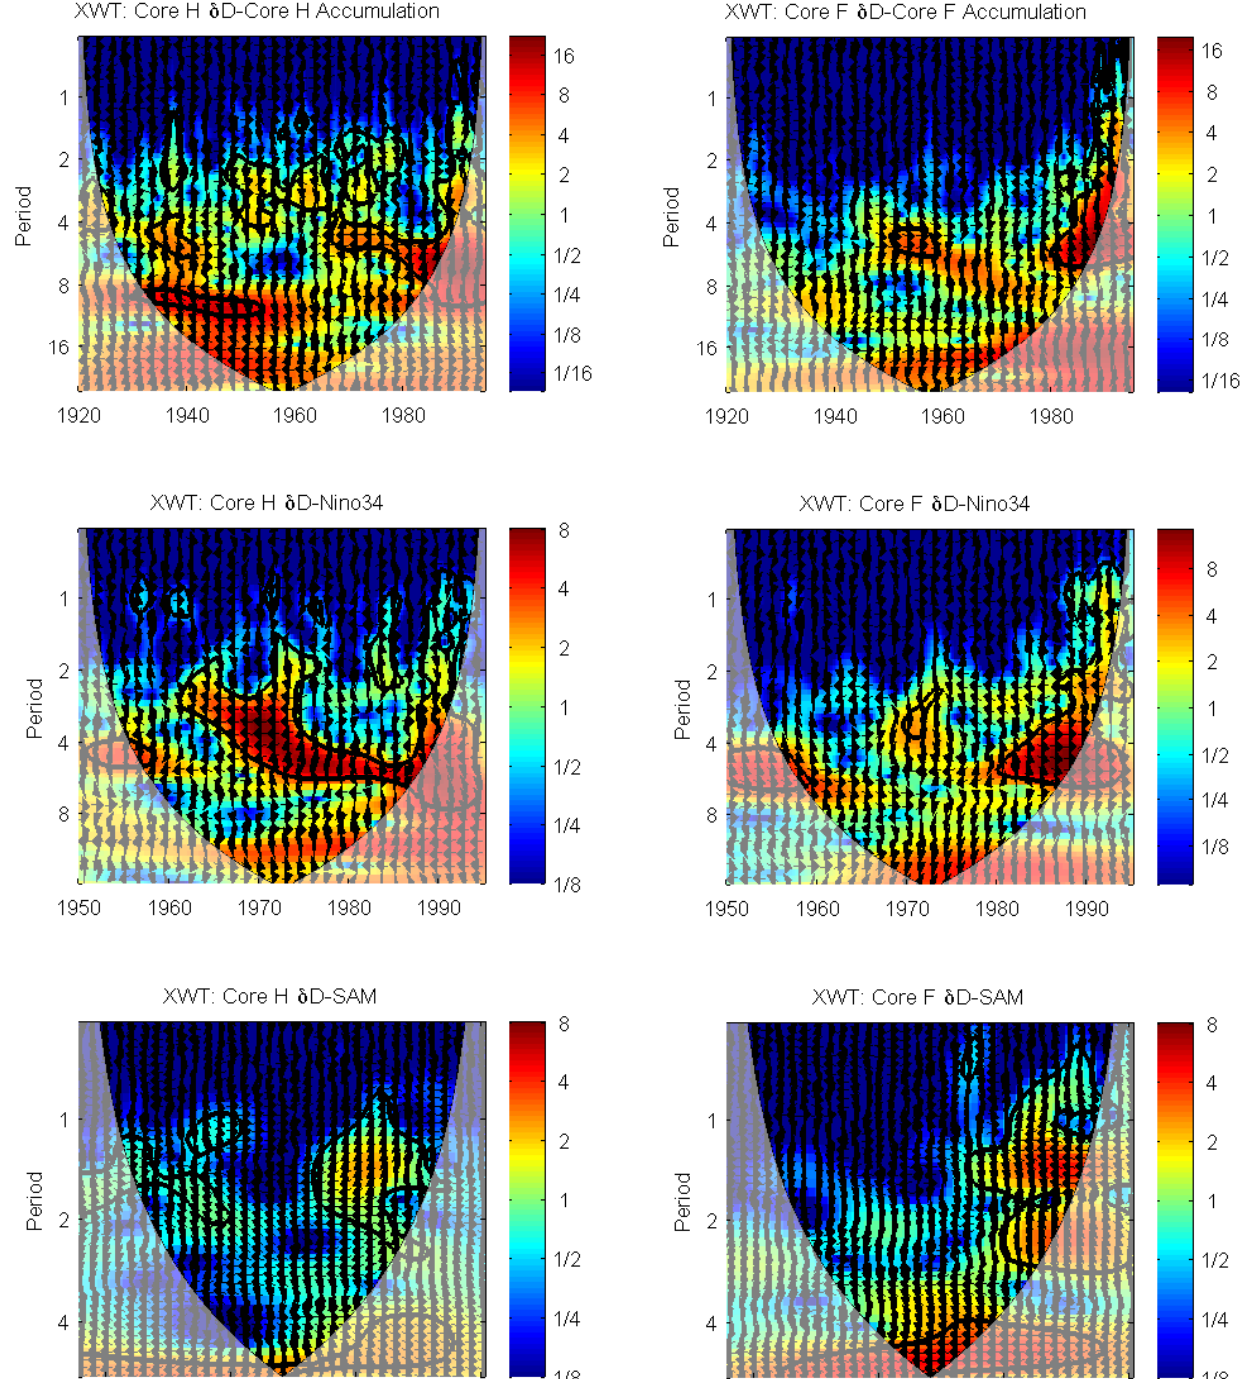
Figure A7. Top panel: core F δ D and core F net accumulation XWT from 1657 to 1995. Middle panel: core F δ D and Niño 3.4 XWT from 1950 to 1995. Bottom panel: core F δ D and SAM XWT from 1979 to